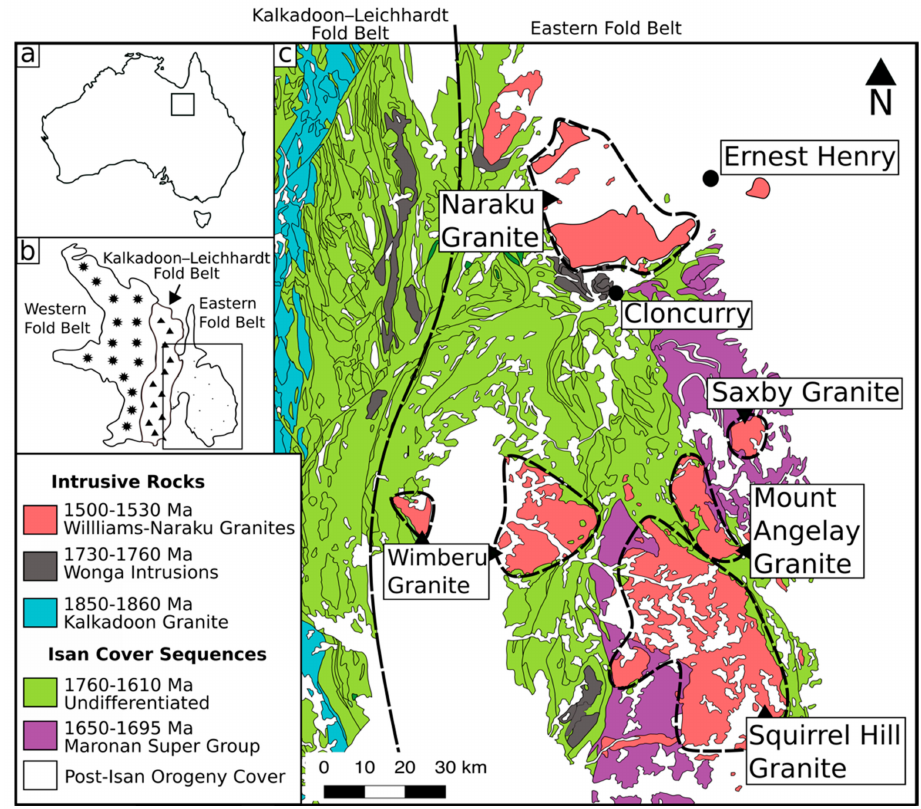
Figure 1. ( a ) The location of the Mount Isa Inlier relative to Australia; ( b ) The location of the Eastern Succession within the Mount Isa Inlier; ( c ) A simplified geological map of the Eastern Succession, modified from Raymond et al.